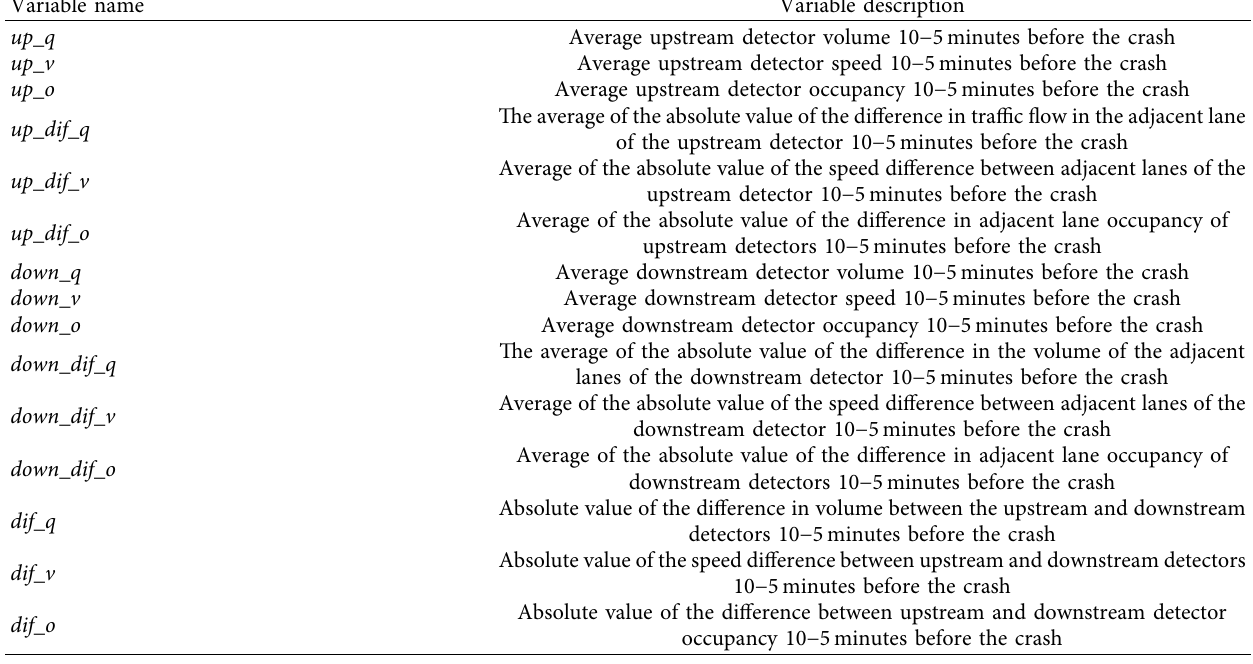
Table 5: Candidate variables of trafc fow.